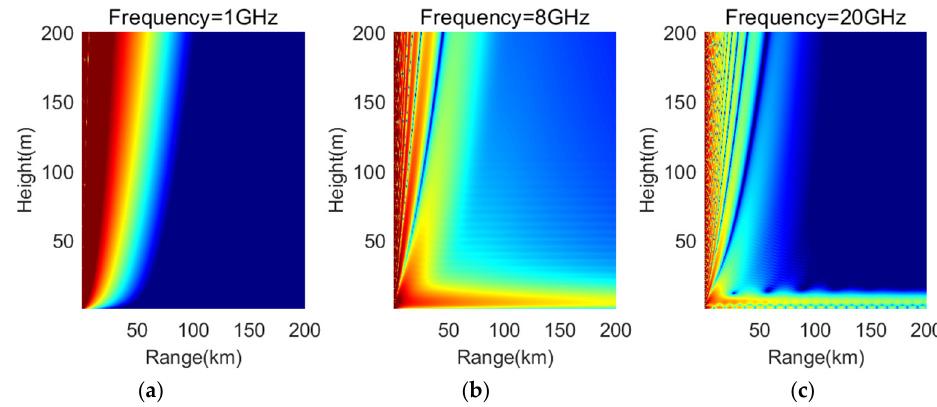
Figure 12. Path loss distributions for surface ducts with di ff erent frequencies: ( a ) frequency of 1 GHz, ( b ) frequency of 8 GHz, and ( c ) frequency of 20 GHz.